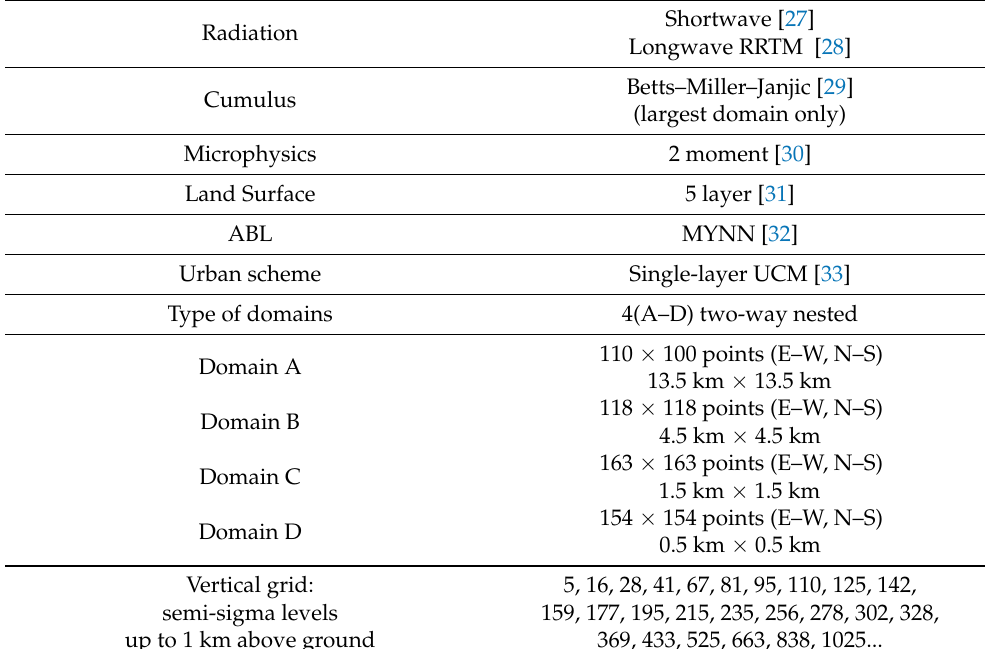
Table 1. Parameters of the WRF